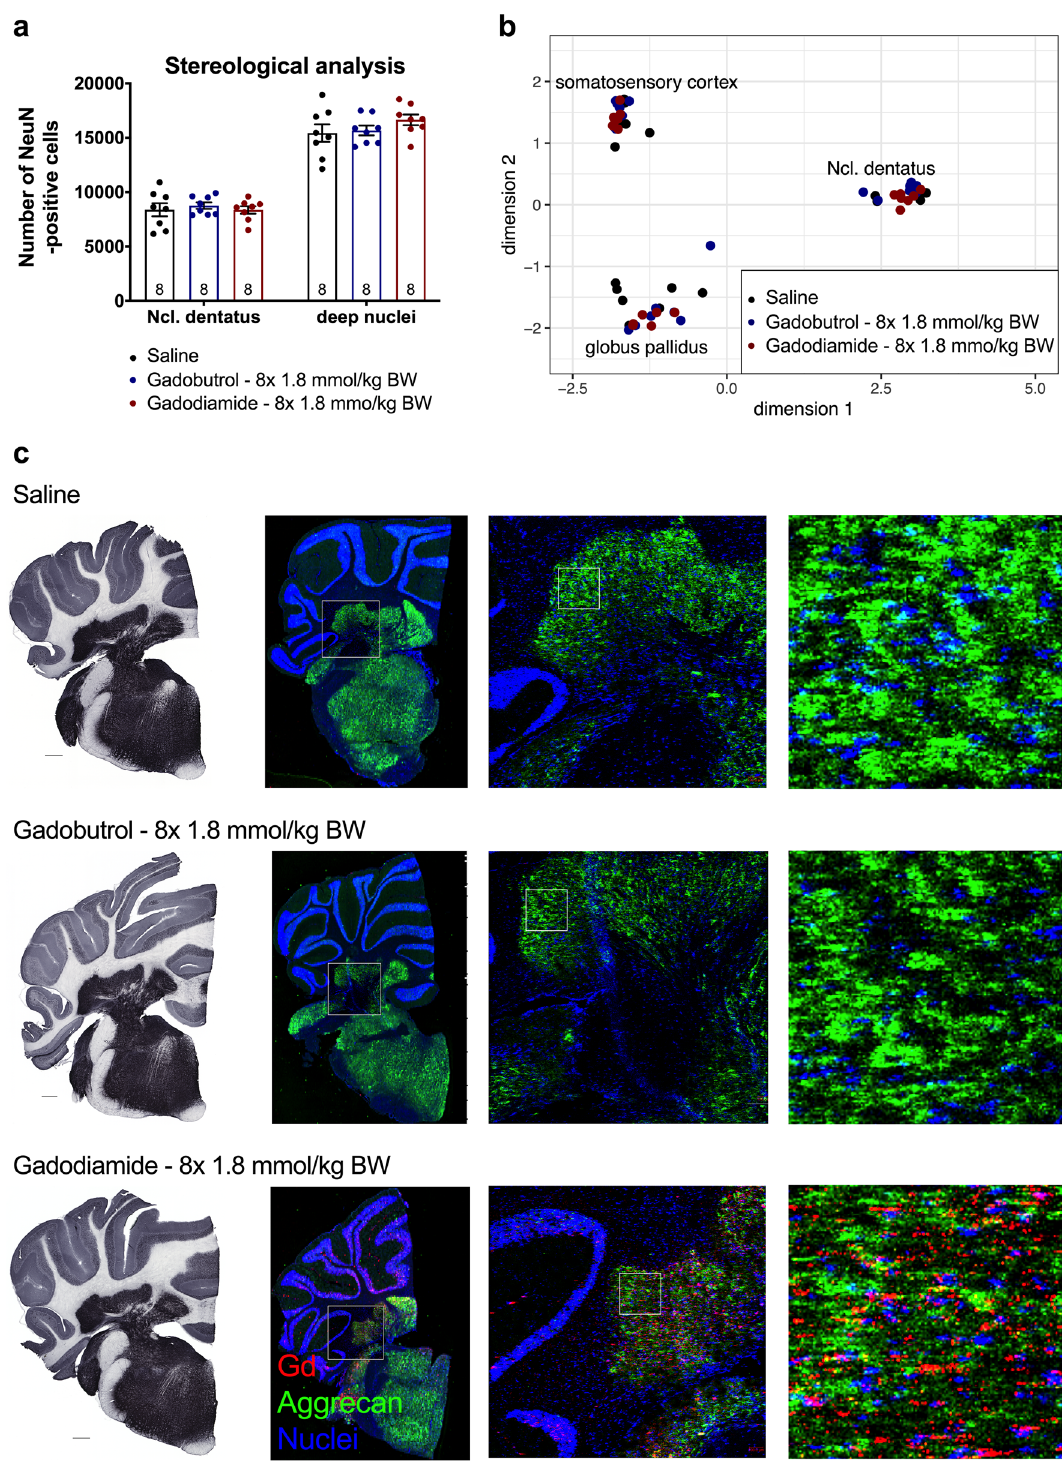
Figure 3. No alterations in number of NeuN-positive cells and gene expression as well as overlap of aggrecan and Gd distribution in the lateral cerebellar nucleus. ( a ) Numbers of NeuN-positive cells in the lateral cerebellar nucleus and adjacent deep cerebellar nuclei of treated and control animals 11 weeks p.i. determined by stereological analysis. ( b ) Gene expression pathway analysis in the lateral cerebellar nucleus, globus pallidus and somatosensory cortex (control region) 11 weeks p.i. ( c ) Conventional immunohistochemistry of aggrecan in the cerebellum of animals sacrificed 11 weeks p.i. (left panel, scale bar: 500 µm). Distribution of Gd and aggrecan in the cerebellum of animals sacrificed 5 weeks p.i. by immunohistological LA-ICP-MS (right panel). Representative pseudo-colored overlays of Gd (red), aggrecan (green) and an iridium containing nucleic acid intercalator (blue) at different magnification. Fields of higher magnification are indicated by squares. Data represent mean ± SEM; n is indicated in the